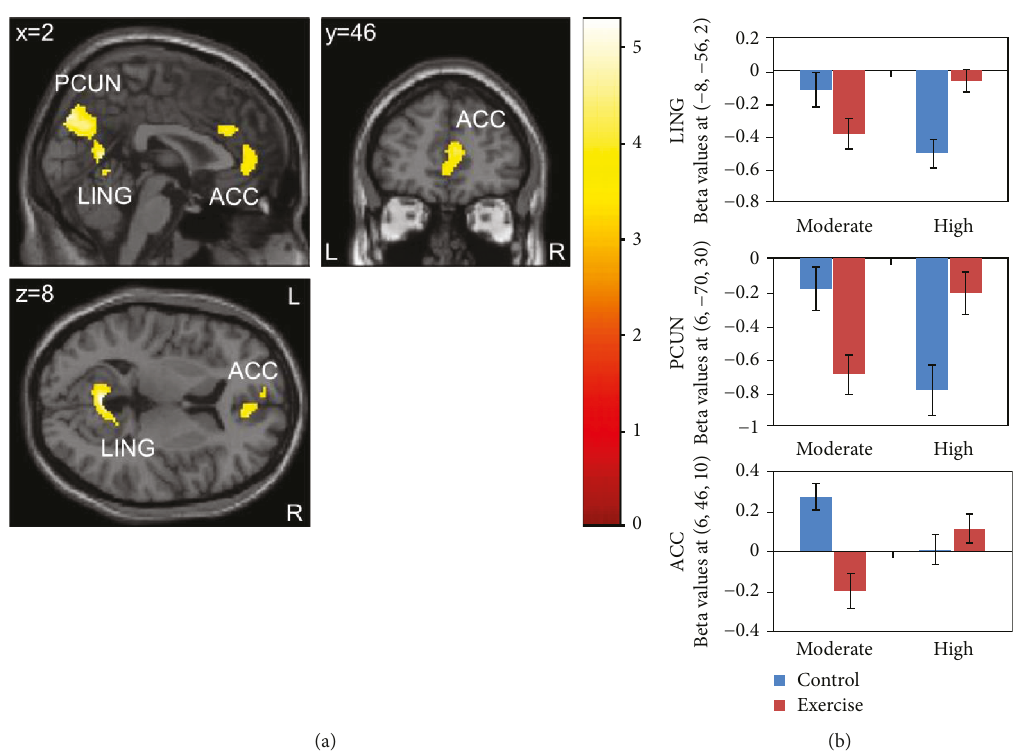
Figure 3: Brain activation during visual stimulation: (a) activation speci fi c to high ( exercise − control ) – moderate ( exercise − control ); (b) mean beta values of peak coordinates with standard error for each group and condition separately. Activation di ff erences were found in three clusters with peak activation in the lingual gyrus (LING), precuneus (PCUN), and anterior cingulate cortex (ACC). p < 0 05 (FWE- corrected on cluster level, initial voxel threshold 0.001 uncorrected). Table 4: Brain activation during the visual task presented directly after each condition (T1). Group,